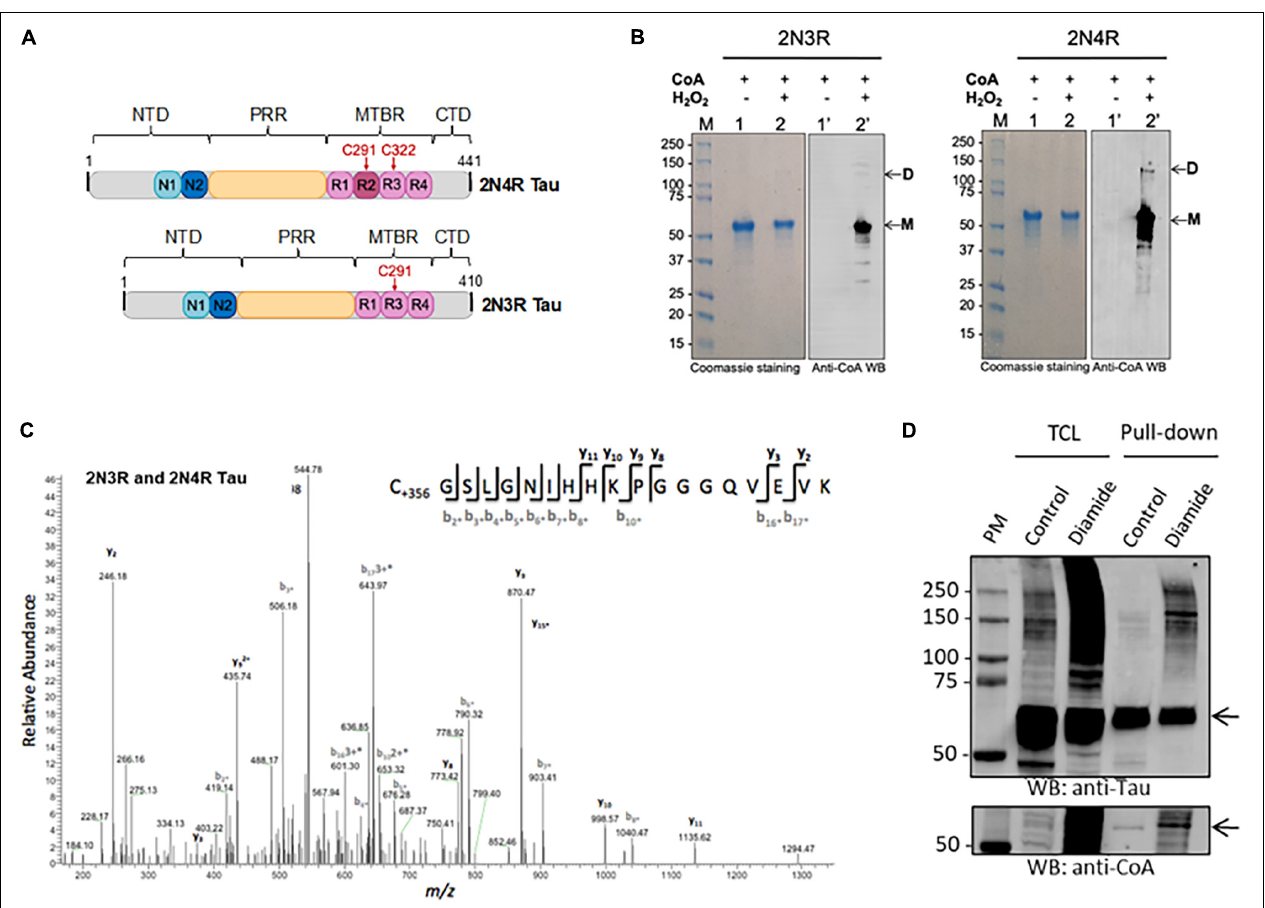
FIGURE 3 | Analysis of tau CoAlation in vitro and in vivo . (A) Schematic diagram of human 2N4R and 2N3R tau isoforms (441 and 410 amino acids in length, respectively). N-terminal inserts, proline rich region (PRR), and microtubule-binding region (MTBR) are shown in blue, yellow, and pink, respectively. Conserved cysteine residues within MTBR are indicated in red. 2N3R tau lacks the second MTBR and thus only features the conserved cysteine residue (in this case, Cys291). N- and C-terminal domains (NTD and CTD, respectively) are shown in gray. (B) In vitro CoAlation of recombinant 2N4R and 2N3R tau isoforms occurs following exposure to hydrogen peroxide. Lane L indicates protein molecular weight marker. Lanes 1 and 1 (cid:48) contain reduced tau in the presence of CoA. Lanes 2 and 2 (cid:48) contain H 2 O 2 - and CoA-treated tau. CoAlated tau remains largely monomeric (M) yet CoAlated dimers are also present for 2N4R (D) . (C) Mass spectrometry analysis of the CoAlated peptide (C*GSLGNIHHKPGGGQVEVK) indicates covalent modification of cysteine (C + 356 ) by CoA at the conserved cysteine residue (Cys322 and Cys291 in 4R and 3R tau, respectively). (D) Transiently overexpressed His-2N4R tau is CoAlated in HEK293/Pank1 β cells exposed to diamide-induced oxidative stress. Total cell lysates and Ni-NTA pulled-down proteins were separated by SDS-PAGE under non-reducing conditions and immunoblotted with anti-CoA and anti-tau12 antibodies. The position of His-2N4R tau in total lysates and pulled-down samples is shown with the arrow. Oligomerization of His-2N4R tau in total lysates and pulled-down samples readily detected with anti-Tau antibodies. TLC, total cell lysate; Pull-down, the use of Ni-NTA affinity beads to pull-down His-tag fusion proteins from cell